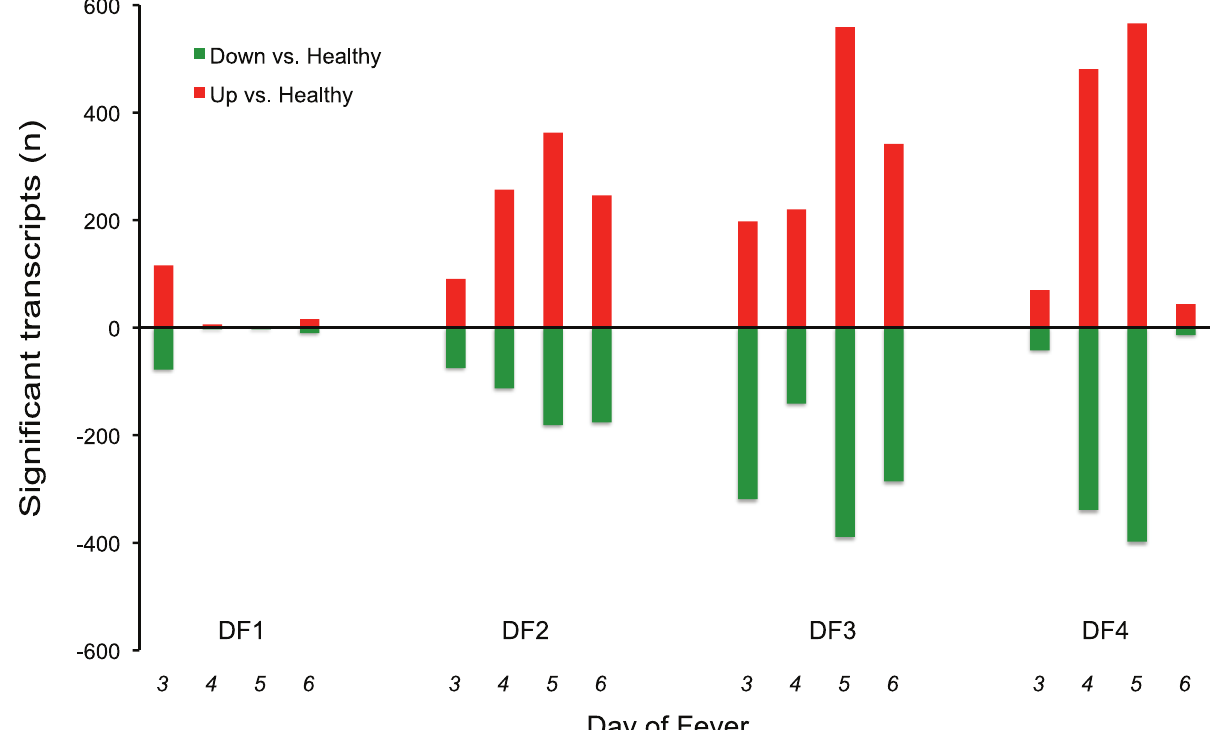
Figure 3. Transcripts with different abundance in each patient group compared to healthy individuals, by fever day. Significant differences in transcript abundance were identified using SAM [32] and a false discovery rate of 1%. Resampling was used to control for differences in sample size [33]. Red bars: transcripts more abundant in dengue patients than in healthy individuals; green bars: transcripts more abundant in healthy